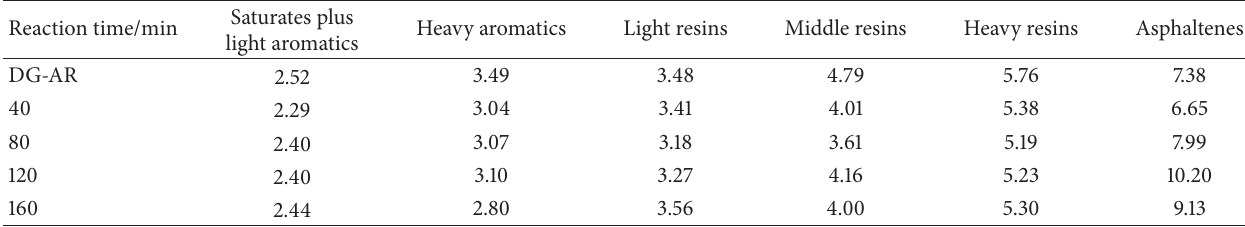
Table 1: Dielectric permittivity of samples of DG-AR thermal reaction at 405 ∘ C.